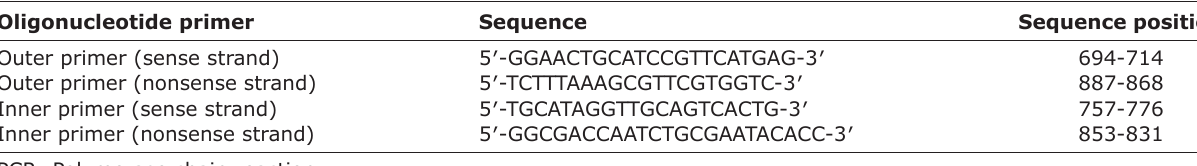
Table-1: Position and sequences of the primer pairs used in nested-PCR. Oligonucleotide